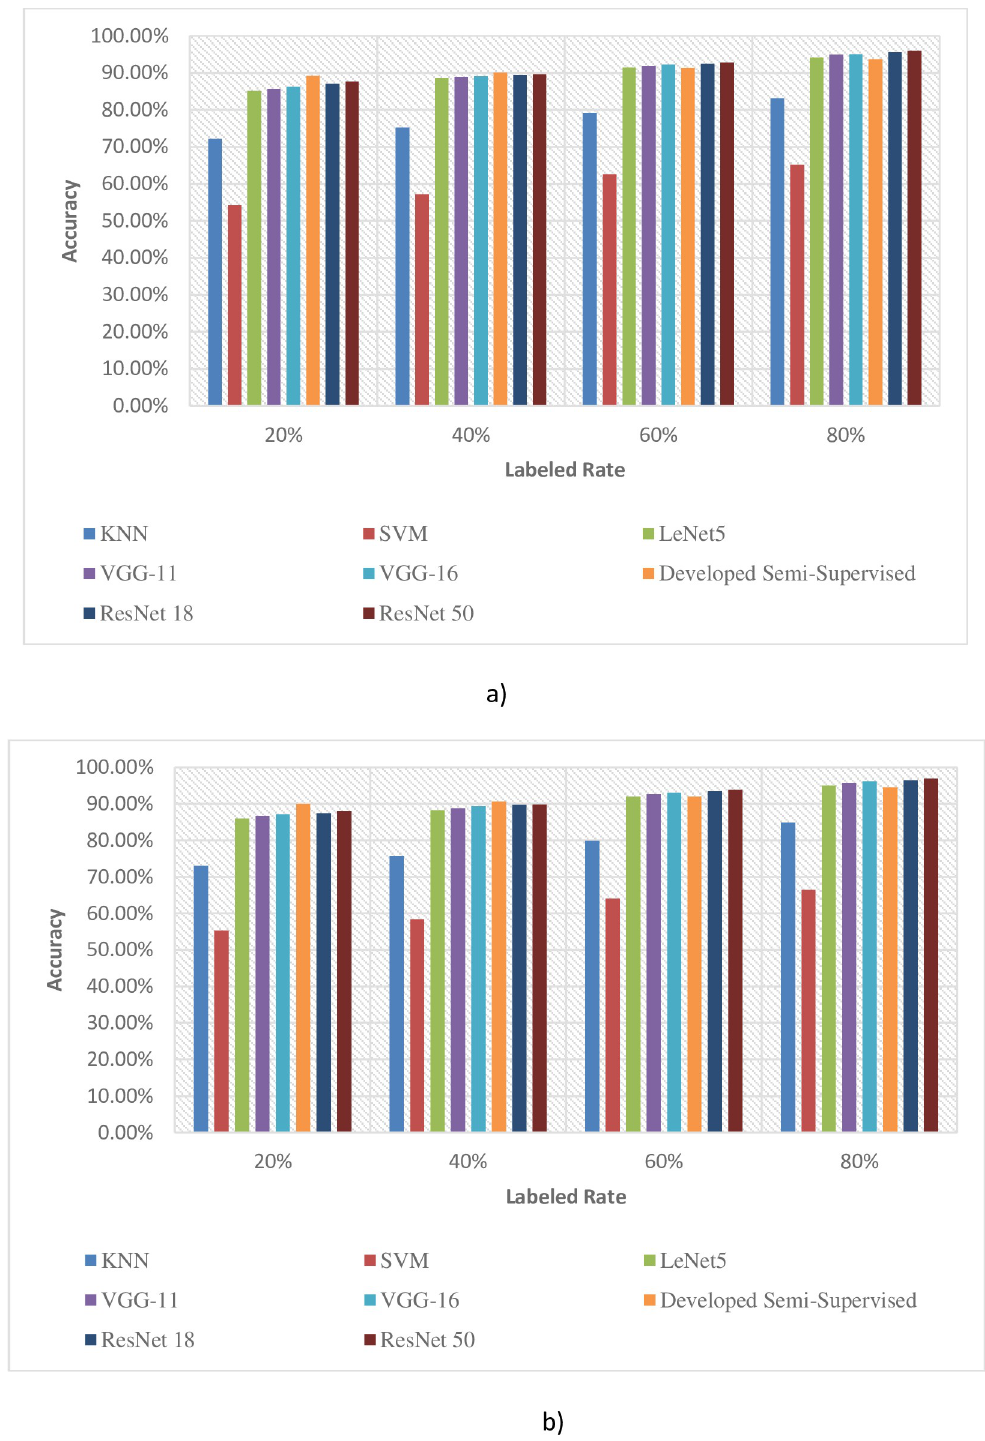
Fig 8. Comparison between SCA and SSCA at different labeled rates. a) Pea. b) Strawberry.